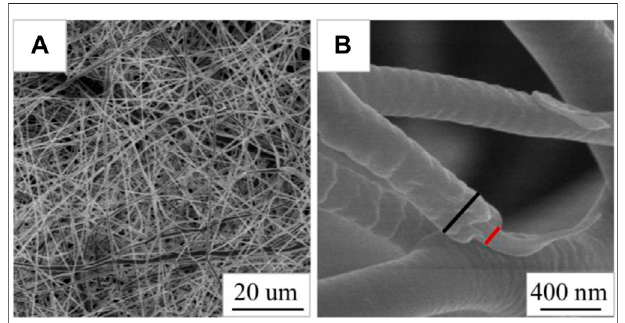
FIGURE 5 | Photographs of antibacterial test result against Staphylococcus aureus (A) blank group, (B) CF2, (C) CF1, and (D) CF3.